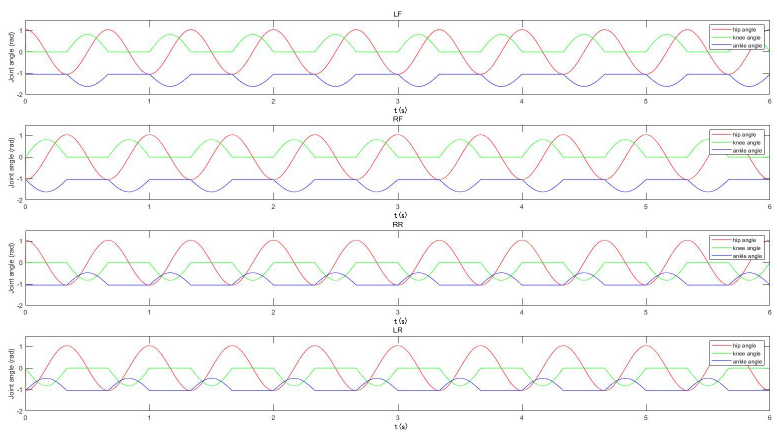
Figure 11. The joint angles in tort